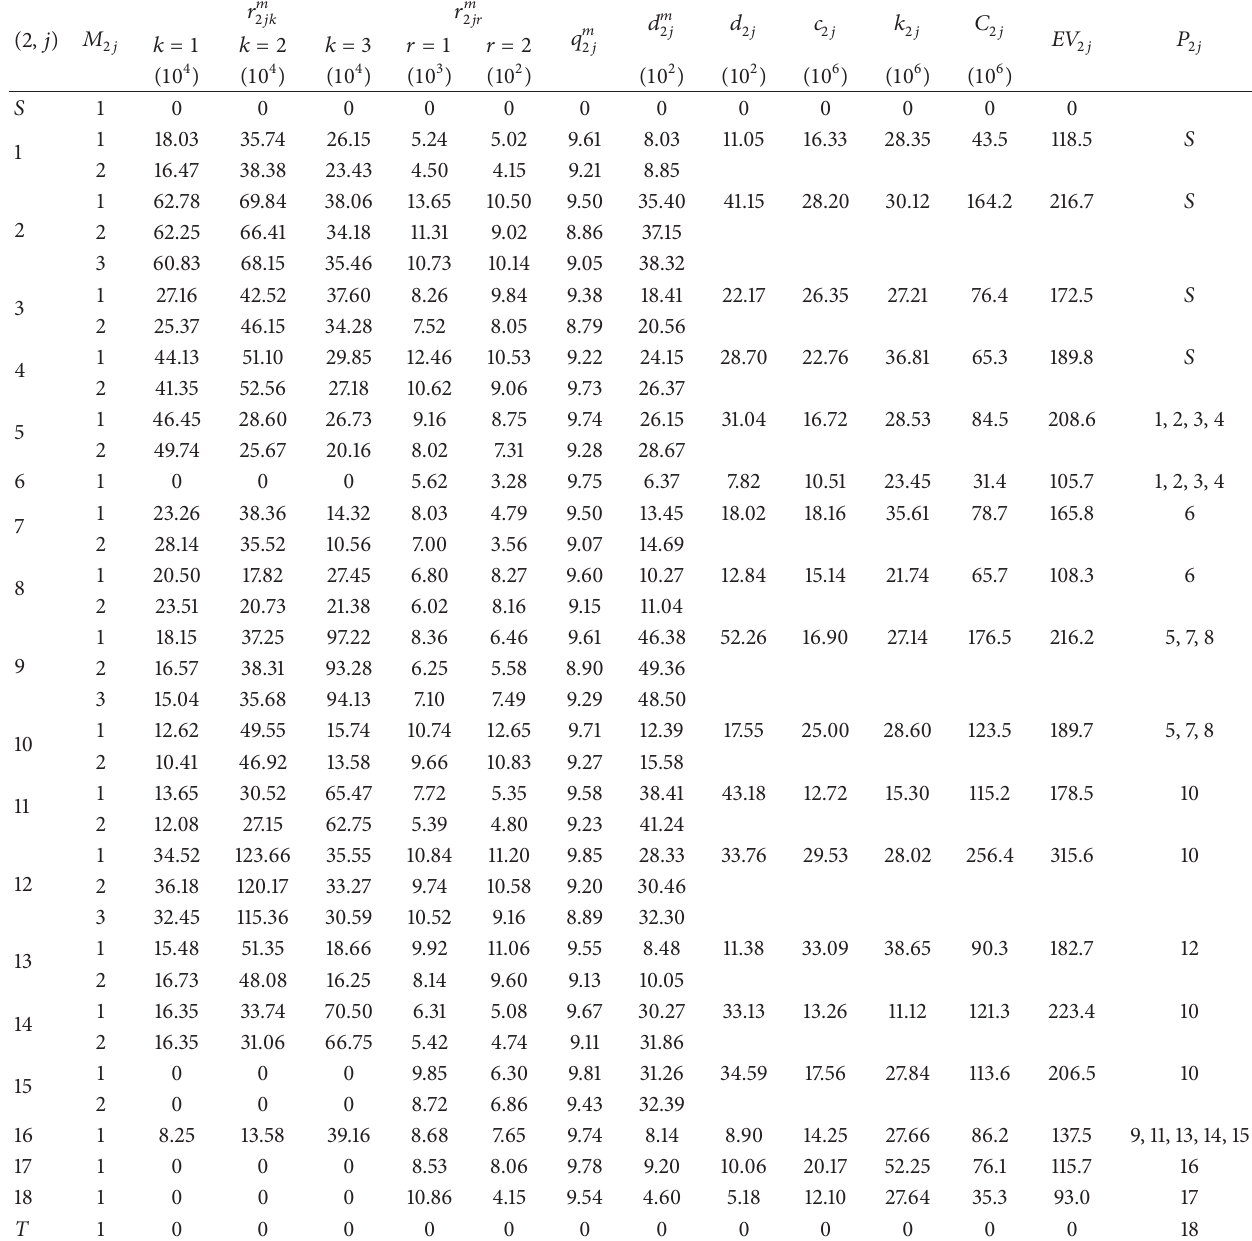
Table 3: Detailed information of each activity in the concrete double-curvature arch dam construction